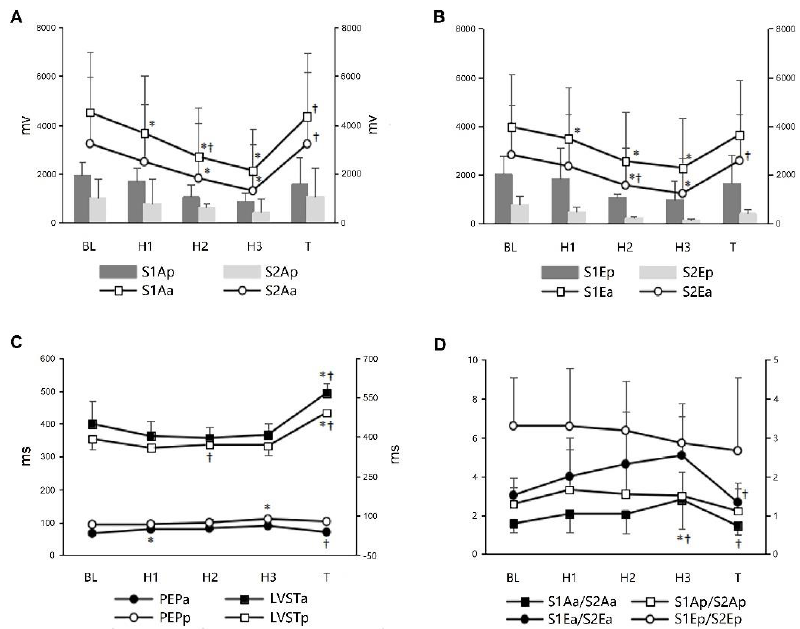
Figure 6. Changes in the S1Aa, S1Ap, S2Aa, S2Ap, S1Ea, S1Ep, S2Ea, S2Ep, PEPa, PEPp, LVSTa, LVSTp, S1Aa/S2Aa, S1Ap/S2Ap, S1Ea/S2Ea and S1Ep/S2Ep during graded hemorrhagic shock and resuscitation. ( A ) The amplitude of S1 and S2 decreased significantly with the graded hemorrhagic shock at A and P spot. S1Aa: S1A at the A spot; S1Ap: S1A at the P spot; S2Aa: S2A at the A spot; S2Ap: S2A at the P spot; ( B ) The energy of S1 and S2 decreased significantly with the graded hemorrhagic shock at A and P spot. S1Ea: S1E at the A spot; S1Ep: S1E at the P spot; S2Ea: S2E at the A spot; S2Ep: S2E at the P spot; ( C ) The pre-ejection period and left ventricular systolic time changes at A and P spot. PEPa: PEP at the A spot; PEPp: PEP at the P spot; LVSTa: LVST at the A spot; LVSTp: LVST at the P spot. ( D ) S1/S2 ratio changes of amplitude and energy at A and P spot. * Significant difference from the baseline ( p < 0.05); † significant difference from the preceding step of protocol ( p < 0.05).